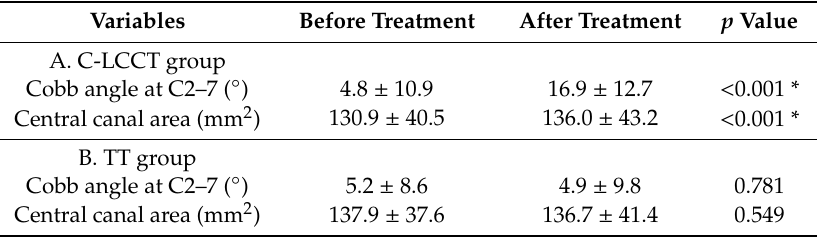
Table 3. Morphological changes (Cobb angle and central canal area) in C-LCCT versus TT group.